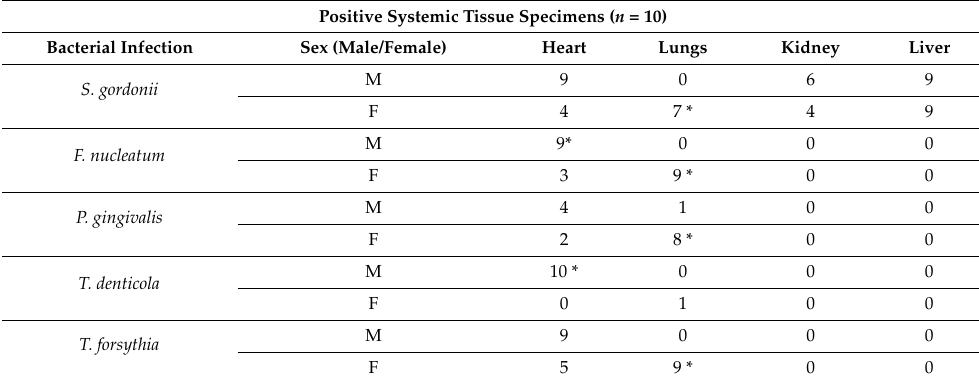
Table 3. Distribution of genomic DNA of periodontal bacteria to distal